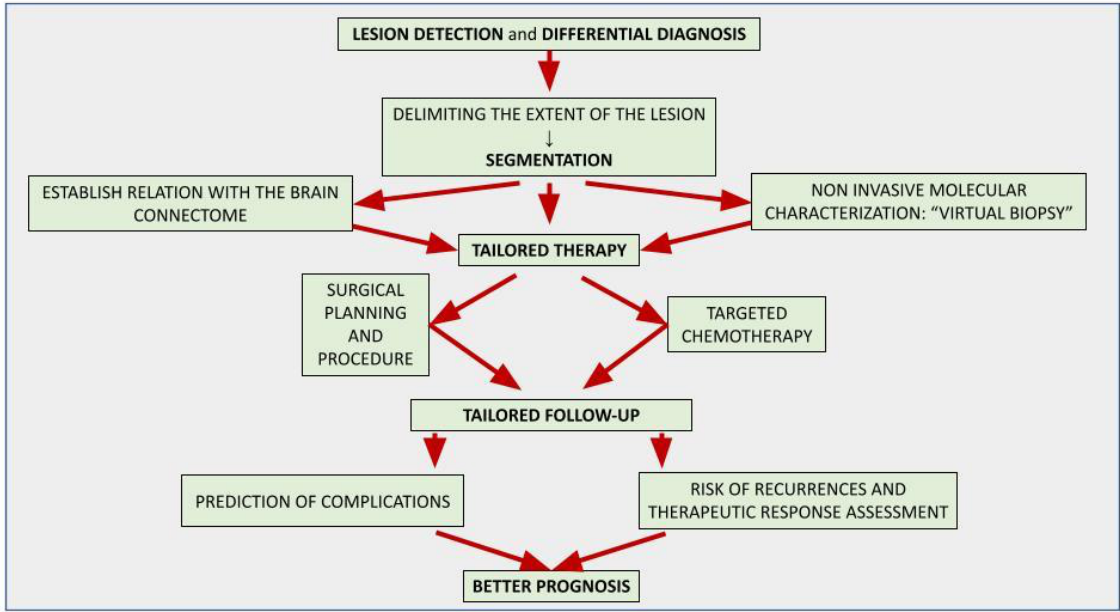
Figure 1. The flowchart in Figure 1 represents the developed AI tools for brain tumor imaging and their aim. The final purpose is to provide customized therapy and follow-up for each patient in order to achieve a good outcome.